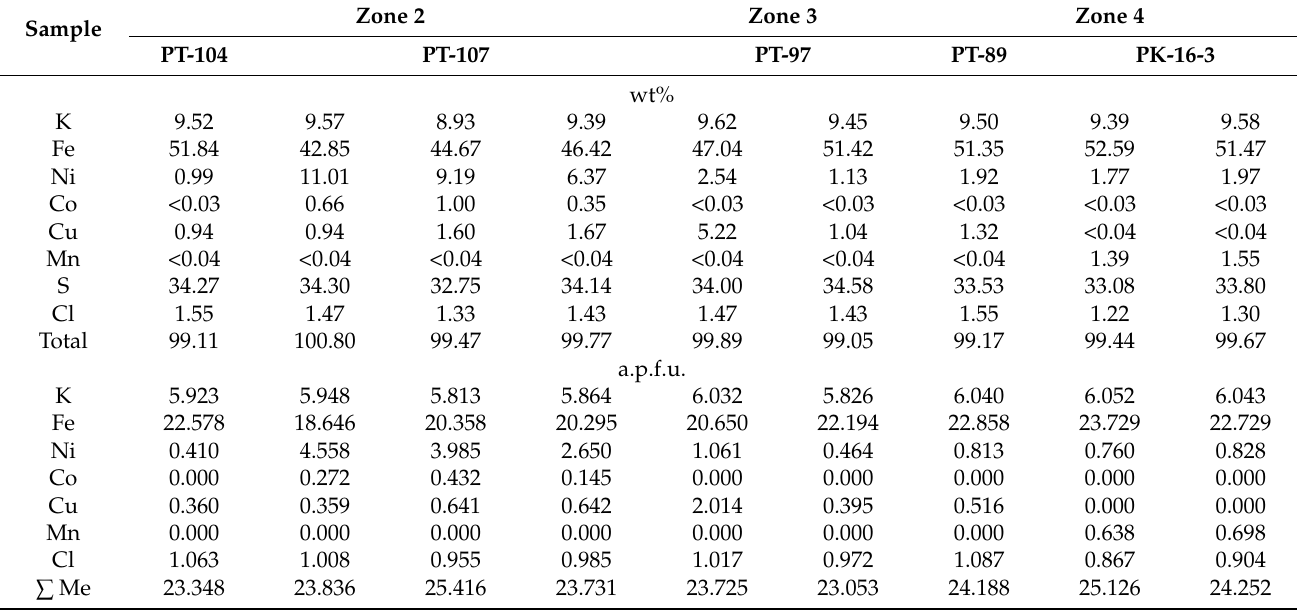
Table 10. Representative analyses of djerfisherite (K 6 (Fe,Ni,Co,Cu) 25 S 26 Cl) from marbles of the Kochumdek contact aureole (EPMA data).